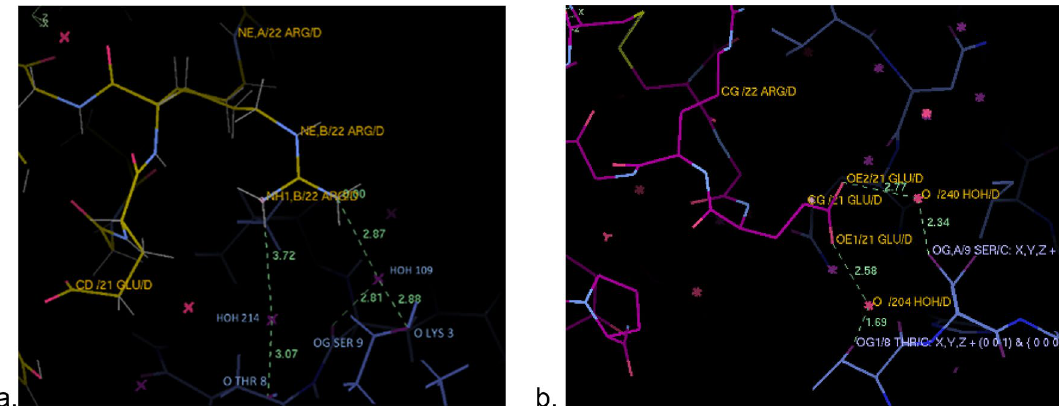
Figure 4. The unique conformation of IGlu D21Glu ( a ) and the native insulin D21Glu PDB:4EY9 ( b ) note their differing interactions through water molecules to a neighbouring protein molecule by symmetry. IGlu in yellow, insulin (4EY9) in pink and the symmetry related one in blue. Figures created using COOT v0.8.9.1.